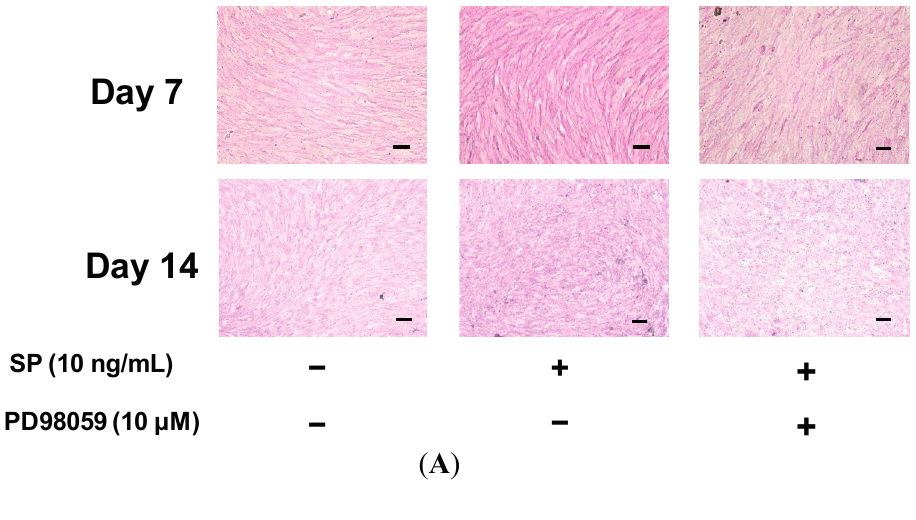
Figure 6. Effect of PD98059 on ALP staining and ALP activity induced by SP. ( A ) Confluent MSCs were stained using an ALP staining kit after 7 or 14 days of cultivation in osteogenic medium containing SP (0 or 10 ng/mL), or SP (10 ng/mL) with the ERK 1/2 inhibitor, PD98059 (10 µM). Scale bar = 100 µm; ( B , C ) ALP activity was measured at 7 or 14 days. To normalize ALP activity, the amount of ALP was normalized to the amount of DNA. * p < 0.05, SP (0 ng/mL) vs. SP (10 ng/mL), † p < 0.05, SP (10 ng/mL) vs. SP (10 ng/mL) with PD98059 (10 µM).